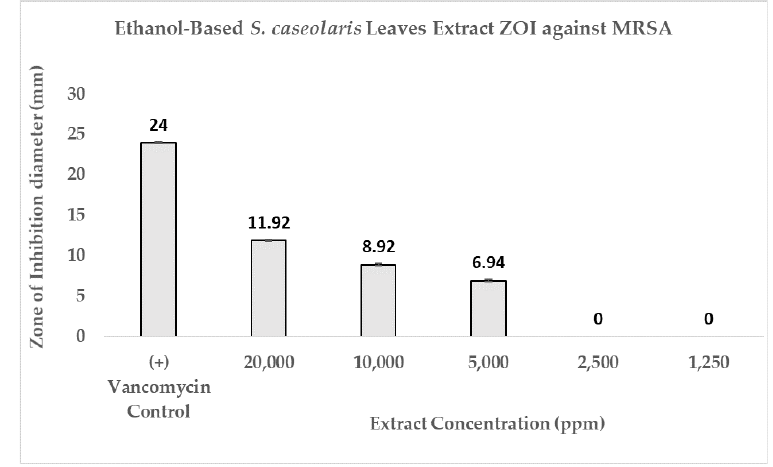
( d ) Figure 3. Documented run for: ( a ) ethanol-based S. caseolaris leaves extract; ( b ) water-based A. ma- rina leaves extract; ( c ) water-based R. mucronata leaves extract; ( d ) water-based R. apiculata leaves extract on LB agar medium grown with MRSA strain. The middle disk labeled C is positive control Vancomycin, while the numbered labels were concentrations of diluted extracts. Label number 1 is the smallest extract concentration at 1250 ppm, number 2 is 2500 ppm, number 3 is 5000 ppm, num- ber 4 is 10000 ppm, and number 5 is the largest concentration at 20,000 ppm. The disks were impregnated with 5000 ppm (3) until 20,000 ppm (5) S. caseolaris ex- tracts were able to inhibit the growth of the MRSA strain, with a diluted extract of 20,000 ppm capable of inhibiting around half the range of control antibiotic Vancomycin. While